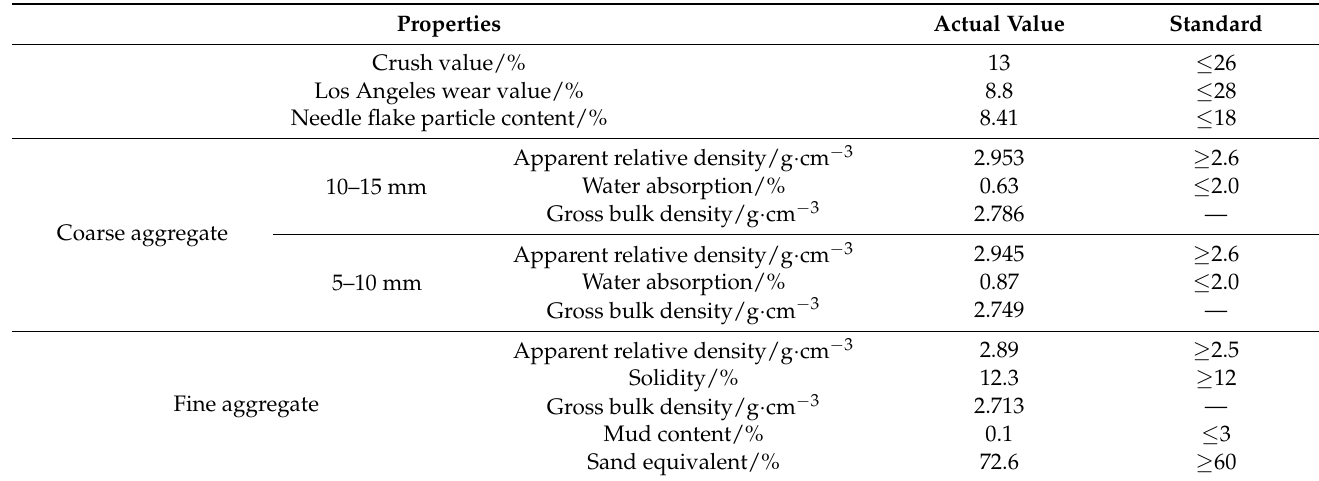
Table 6. Properties of aggregate.